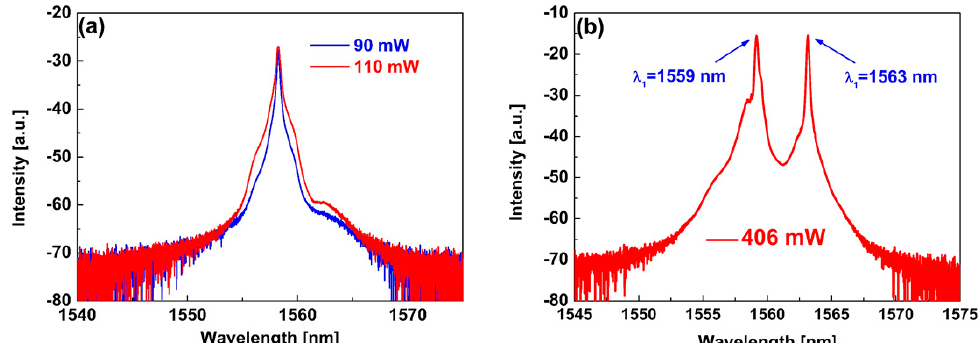
Figure 5. Pulse trains at different pump power.